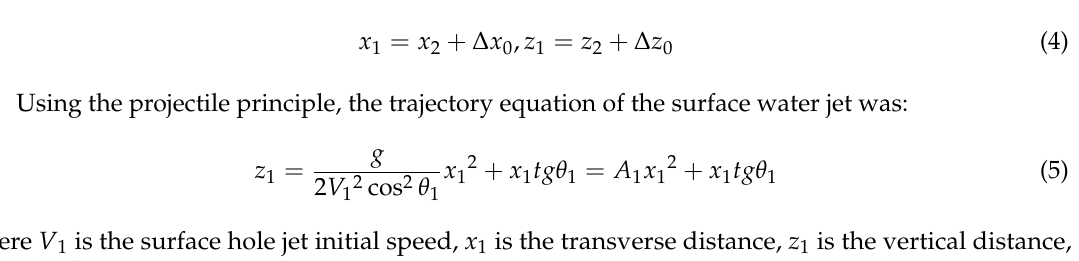
Figure 9. Schematic diagram of the collision between the surface-hole jet and the deep-hole jet in air. The coordinate systems x 1 0 z 1 and x 2 0 z 2 , in Figure 9 have the following geometric relationship: